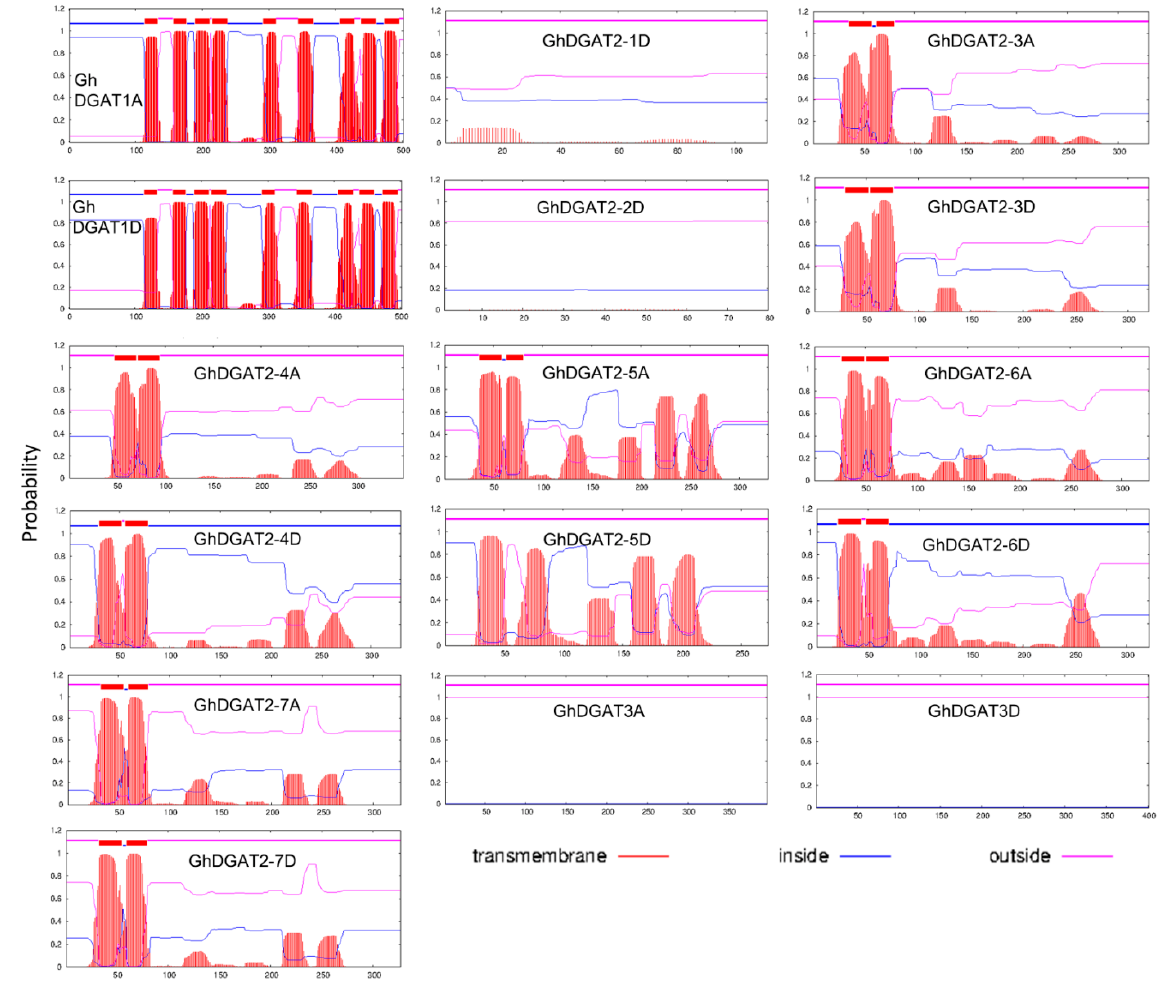
Figure 4. Predicted transmembrane domain for GhDGAT proteins. Regions of GhDGAT amino acid sequences predicted to be located inside or outside the membrane are shown in blue and pink, respectively.